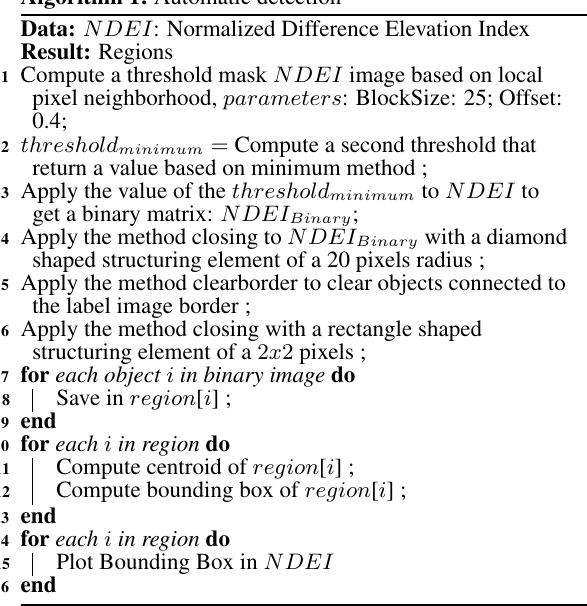
Algorithm 1: Automatic detection